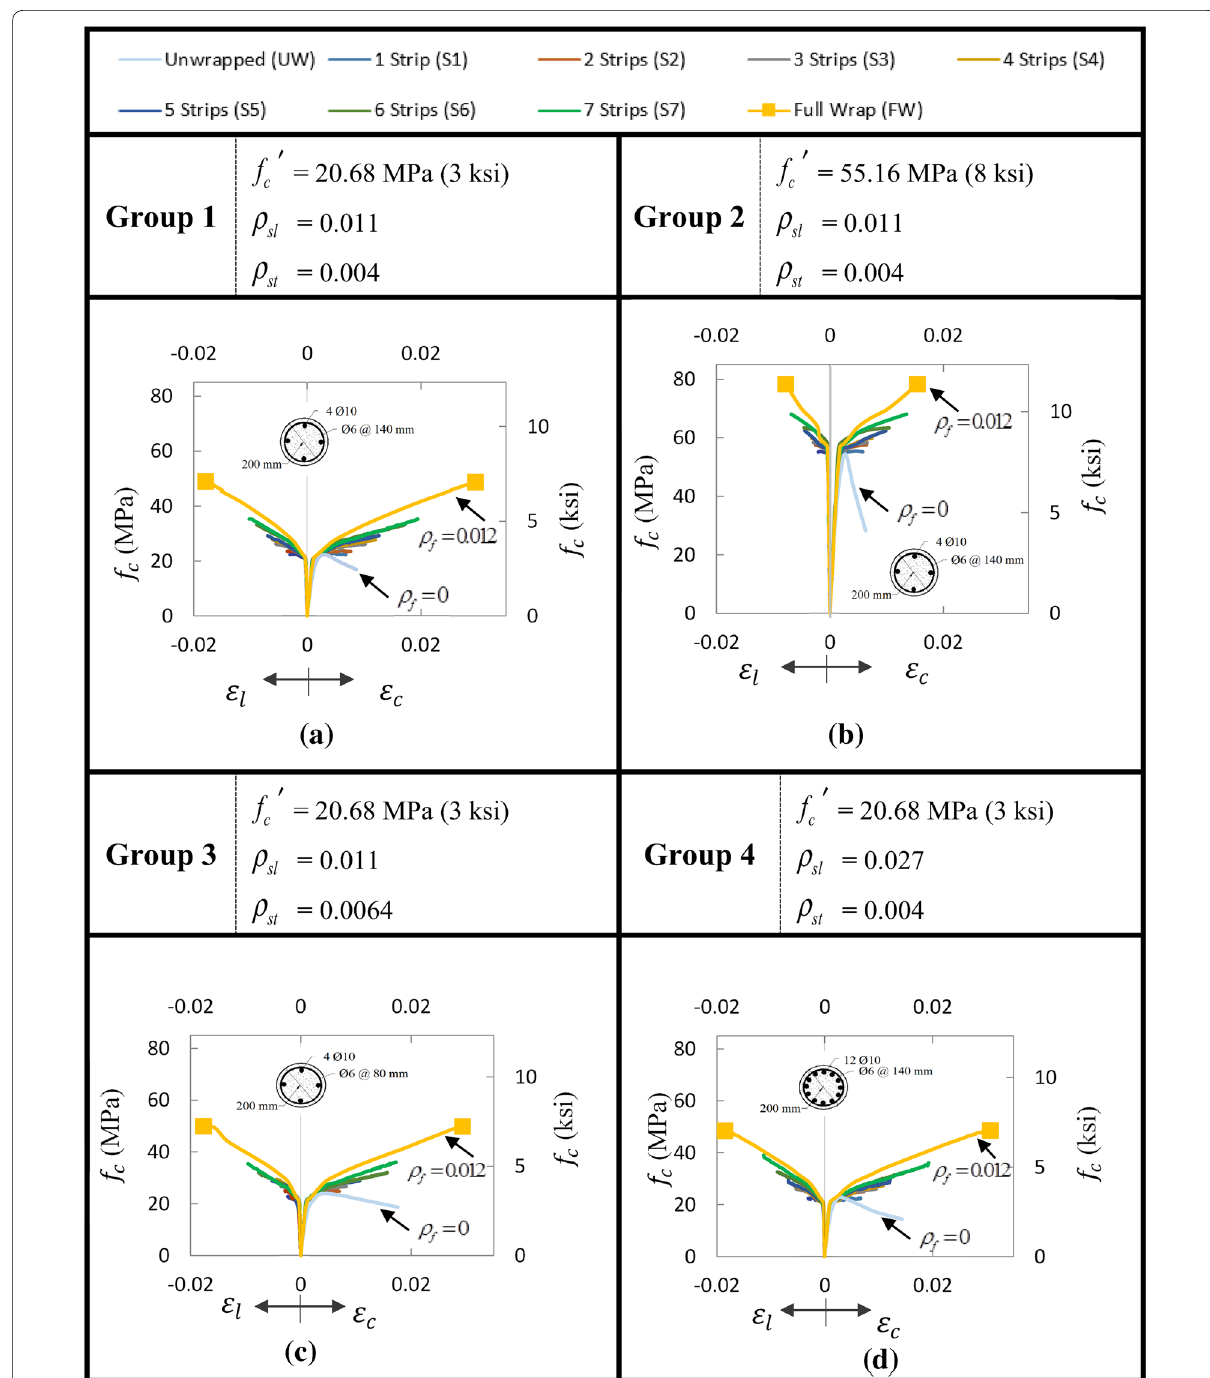
Fig. 3 Comparison of compressive stress ( f c ) vs. axial strain (ε c ) and lateral strain (ε l ) for the columns in a Group 1, b Group 2, c Group 3, and d Group 4. Note Refer to Fig. 2 for ρ f